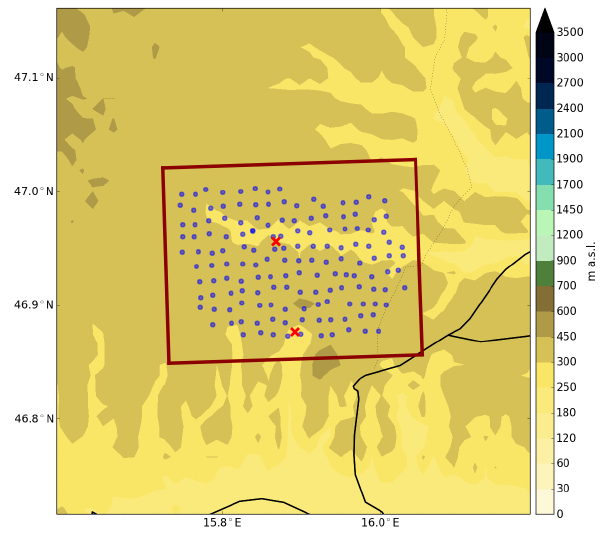
Figure 1. Rapid-INCA topography in the WegenerNet region. Blue circles represent WegenerNet stations, red crosses are the TAWES stations (Teilautomatische Wetterstationen) Feldbach (north) and Bad Gleichenberg (south) of